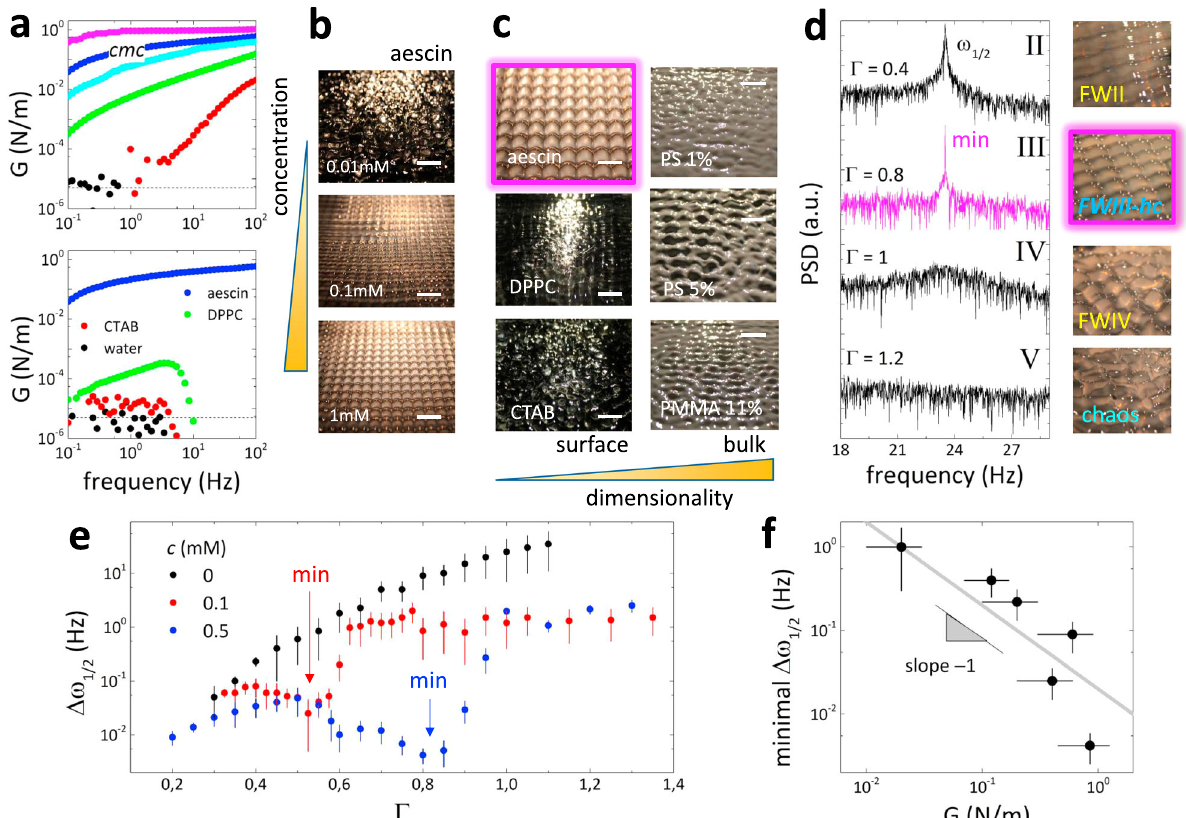
Fig. 5 Hydrodynamic crystals: surface stiffening and spectral narrowing. a Linear interfacial rheology (see Supplementary Note 3) of aqueous solutions for different aescin concentration (top panel), and different surfactants as CTAB and DPPC (lipid) at equivalent concentration as the surface tension of the aescin solution at cmc = 0.4 mM ( σ ≈ 30 mN m − 1 ; lower panel). The surface stiffness ( G ) varies by several orders of magnitude from the highest saturation value G ≈ 1 Nm − 1 at 1 mM concentration ( ≈ 2.5 cmc; magenta dots), 0.4 mM ( ≈ ; blue dots), 0.1 mM (cyan dots), 0.05 mM (green dots) down to 0.01 mM (red dots). The black dots correspond to the bare water surface, which are compatible with the instrumental sensitivity (ca. 5 μ N m − 1 ). b Surface waving images at different aescin concentration (lateral yellow bar height is proportional to the concentration) under driving frequency ω 0 = 47 Hz and acceleration Γ > Γ F , which both allow the formation of square-lattices of hydrodynamic crystals at G ≥ 0.1 Nm − 1 , corresponding to aescin concentrations c ≥ 0.1 mM ≈ 0.25 cmc. c Surface waving images with aescin at c ≈ cmc leading to hydrodynamic patterns, and two surfactant additives (CTAB and DPPC) unable to harness surface ordering at equivalent surface tension ( σ ≈ 30 mN m − 1 ). The right panels compare the disordered waves obtained with concentrated colloidal suspension entailing a bulk frictional skeleton. The bottom yellow bar height is proportional to the system dimensionality, from 2D to 3D. d Subharmonic peak ω 1/2 and corresponding surface image for different Γ in β -aescin solutions at c ≈ cmc (the different FW-states were tested; from II to V). The hydrodynamic crystals in the pure Faraday state show the maximum structural stability characterized by the minimum peak broadening (at Γ = 0.8; magenta line). e Full-width at half-maximum of the subharmonic peak ( Δ ω 1/2 ) as a function of Γ for the bare water surface (black dots), and A/W interfaces functionalized with aescin at 0.1mM (red dots) and 0.5mM (blue dots). The minimum values determine the maximal crystal ordering. The error bars correspond to the uncertain in the peak linewidth obtained as the standard deviation over 5 measurements. f Minimum value of Δ ω 1/2 in ( e ) as a function of aescin concentration, reported in terms of G . The vertical and horizontal error bars are due to the estimation of the minimum value of Δ ω 1/2 and to the uncertain in the rheological experiment reproducibility. The solid line with the expected linear dependence between crystal order and shear rigidity represents a guide to the eye; for higher G the minimum of Δ ω 1/2 decreases, which corresponds to a more stable and ordered hydrodynamic crystal upon stiffening the surface skeleton with increasing aescin